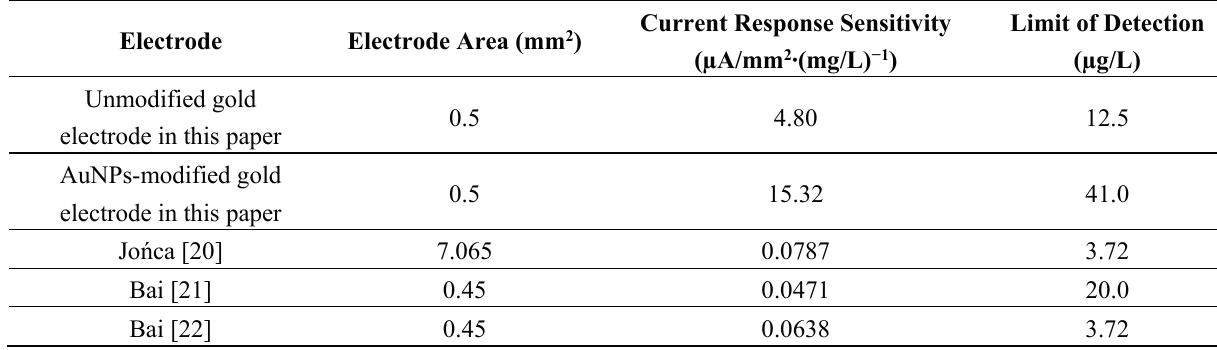
Table 1. The current response sensitivities of different gold microsensor for phosphate detection.